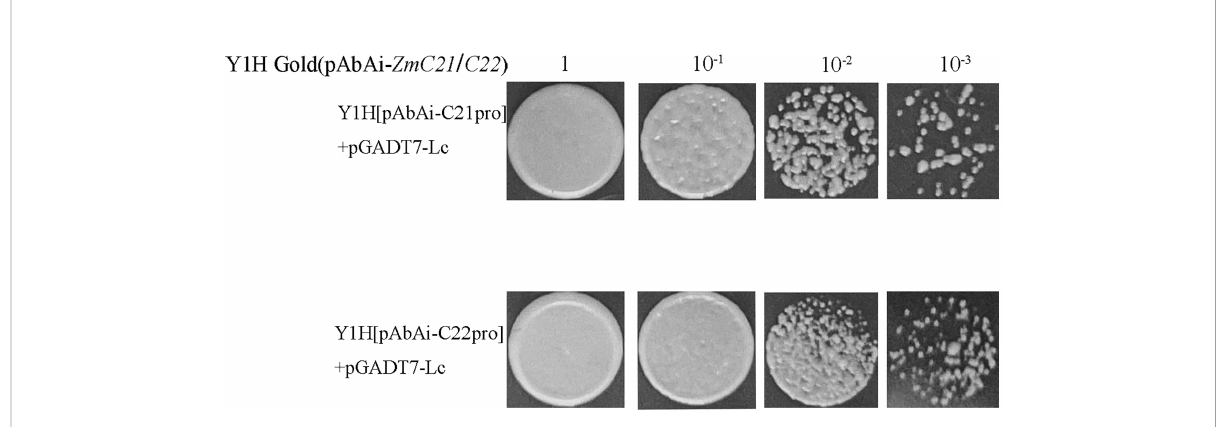
FIGURE 11 The yeast one-hybrid assays of in vivo interaction between ZmLc and the target promoter of ZmCHS . ZmC21 and ZmC22 represented the different region and sequences of the promoter for ZmCHS